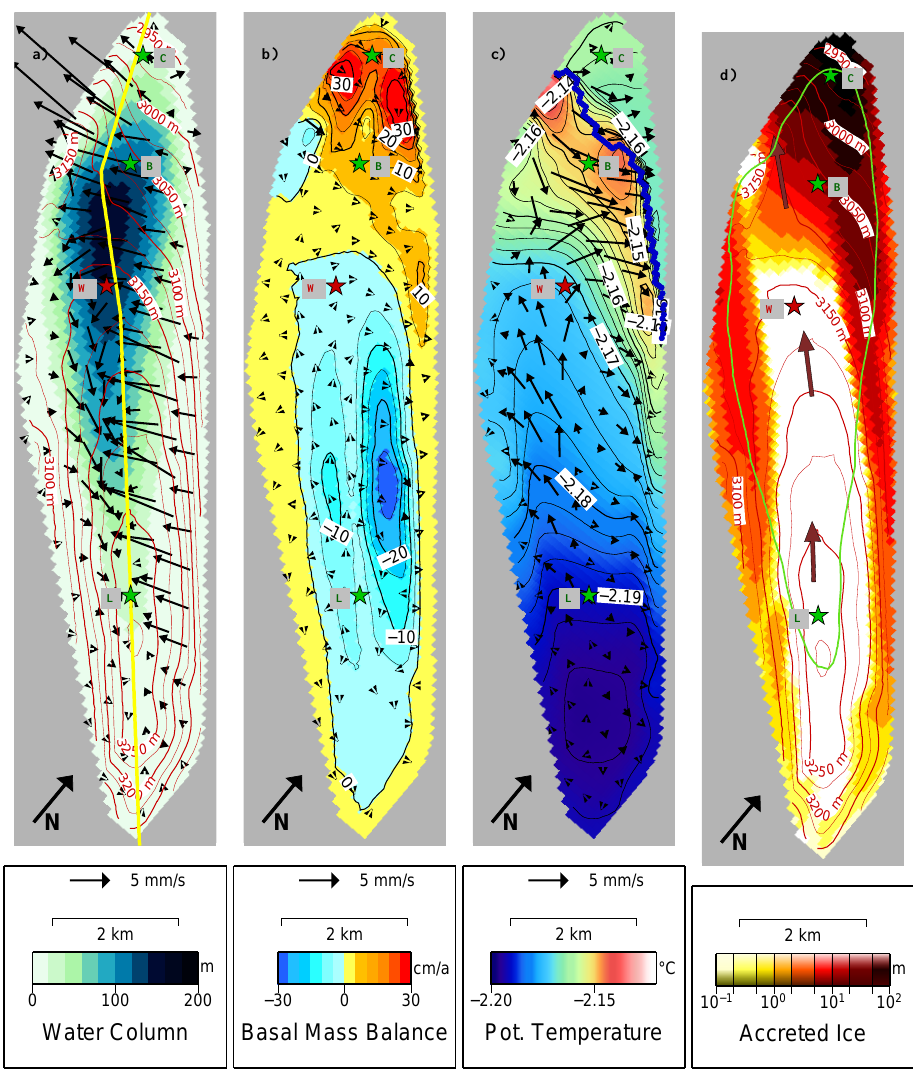
Fig. 2. a) Water column thickness (colour coded) and ice thickness (red contours) of SLE according to Woodward et al. (2010). The yellow line indicates the cross section path shown in Figure3. Arrows indicate flow in the bottom layer. b) Modelled basal mass balance at the ice-lake interface. Negative values indicate melting, positive values freezing. Arrows indicate the flow in the middle of the water column. c) Modelled lake temperature at the ice-lake interface. The blue tipping depth line indicates the area where the line of maximum density (L O MD) intersects the ice-lake interface. Arrows indicate water flow at the ice-lake interface. d) Modelled accreted ice thickness, assuming an ice flow of 5.5m/a. Arrows indicate ice flow direction. The green line indicates the 15m water column thickness. Lake access points suggested by (Woodward et al., 2010, (red)) and in this article (green) are indicated and annotated.